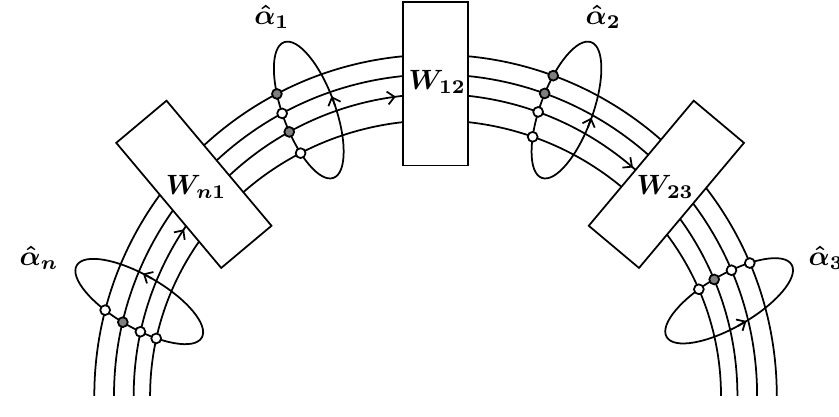
Figure 2 . The Cayley graph in S L formula, generated by f ^ (cid:11) i g and f W ij g . Gray circles represent the scalar (cid:12)elds, and white circles the identity